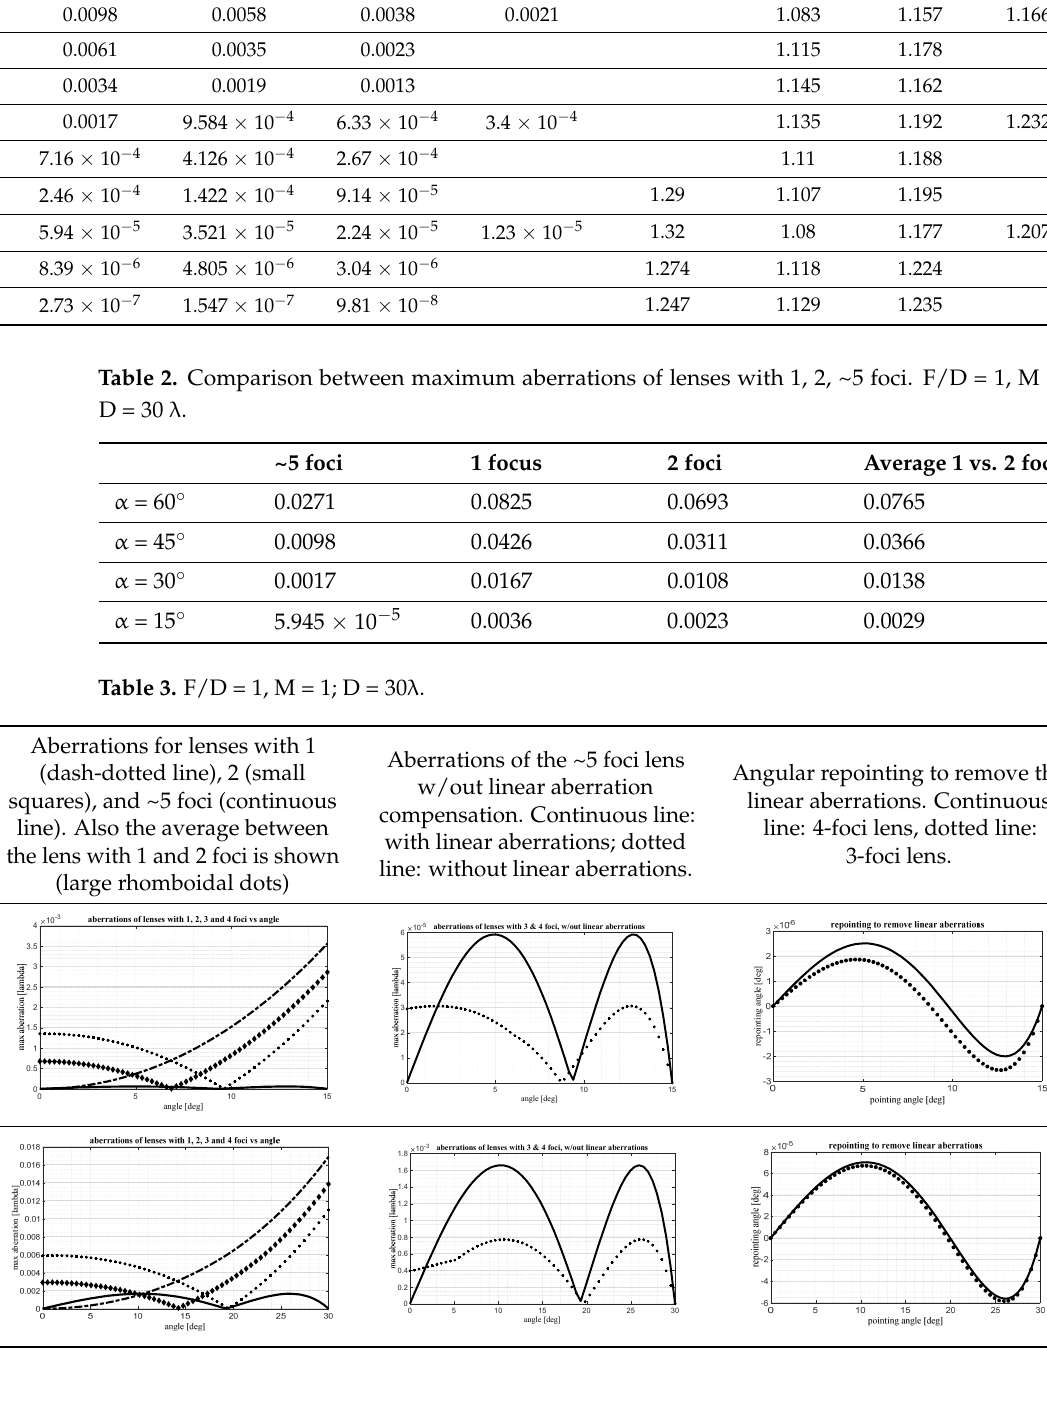
Table 2. Comparison between maximum aberrations of lenses with 1, 2, ∼ 5 foci. F/D = 1, M = 1; D = 30 λ .